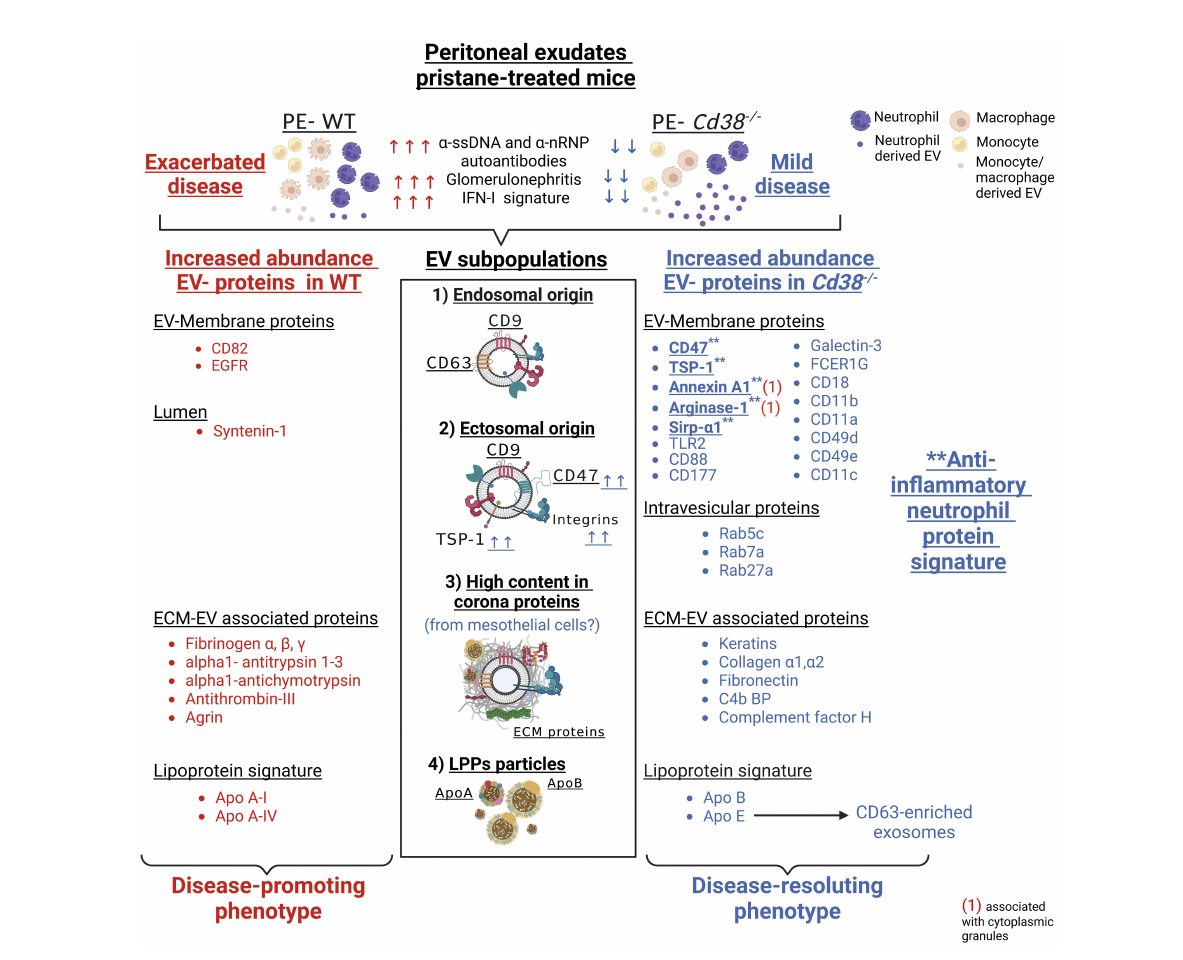
FIGURE 14 Schematic representation of the major fi ndings of this study. Proteins were assigned to the different types of EV and lipoprotein particles present in peritoneal exudates from pristane-treated WT mice (highlighted in red, left) versus CD38-de fi cient mice (highlighted in blue, right), as suggested by the quantitative proteomic comparison analyses. Syntenin-1, which is considered by some authors as a putative universal exosome marker, was exclusively detected in F5-12 WT EVs (crude data available in ProteomeXchange repository, see below). Only a fraction of the proteins, which are part of the neutrophil protein signature, are shown. ** highlights the proteins of the anti-in fl ammatory neutrophil protein signature, which have been considered of special importance in the discussion section. (1) These cytosolic proteins are associated with cytoplasmic neutrophil